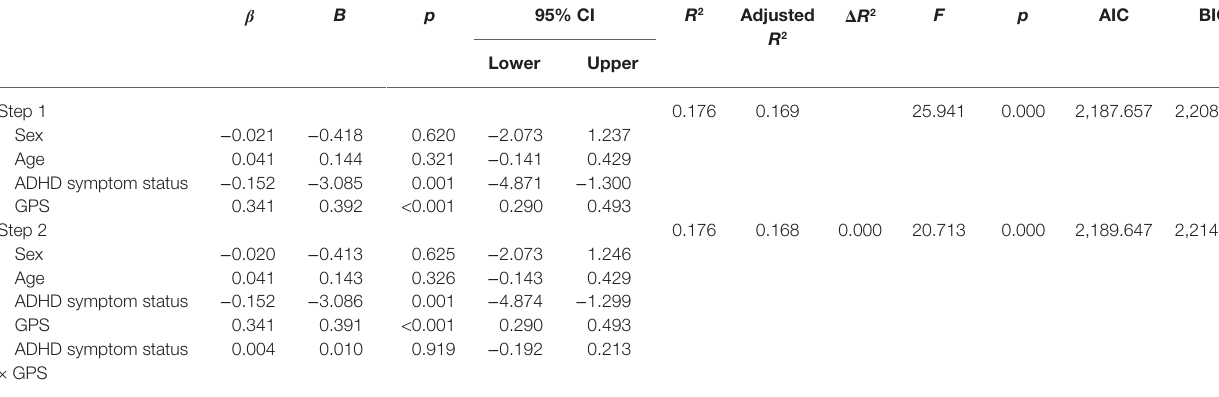
TABLE 4 | Attention-deficit hyperactivity disorder symptom status, procrastination, and their interactions with STAI-T. β B p 95% CI